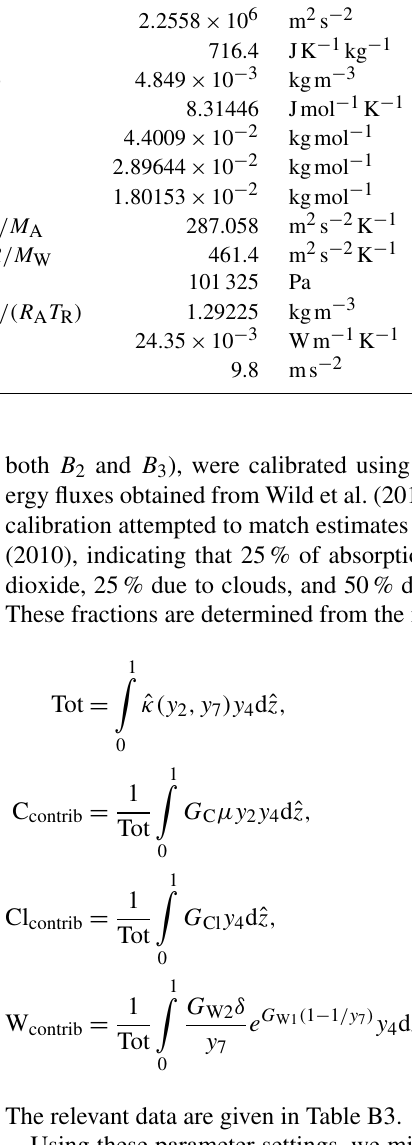
Table B1. Physical constants used in the model. Parameter Symbol Reference temperature